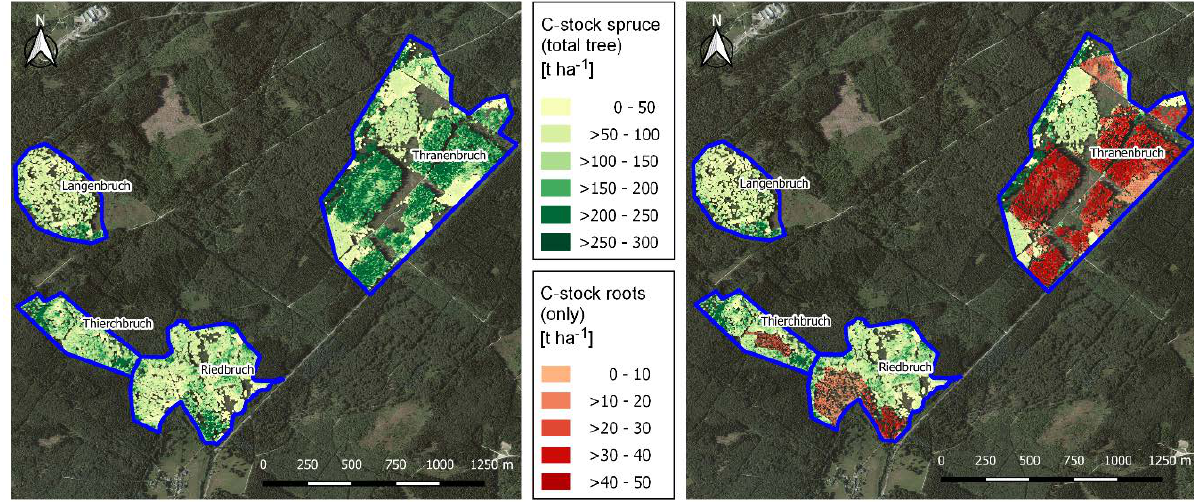
Figure 7. Distribution of spruce forest carbon stocks at monitoring sites before and after tree removal. Red areas indicate tree removal with loss of biomass carbon and leaving roots (C-stocks of roots) on the